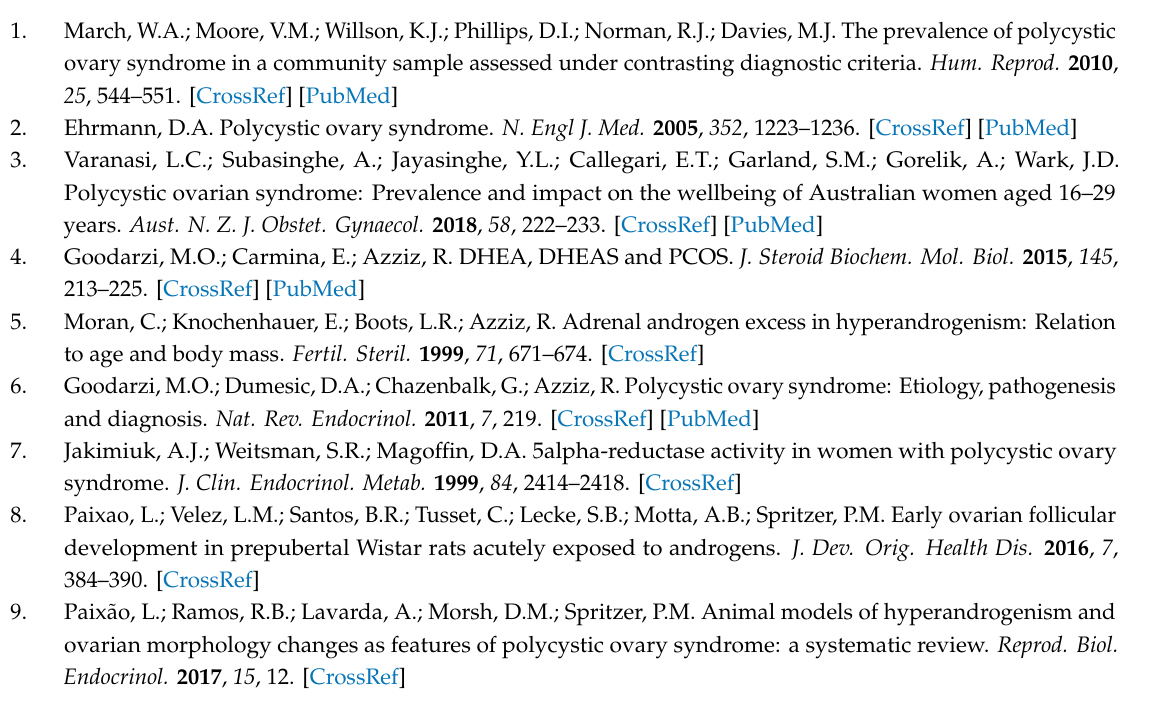
Figure S1: The property of AGE products. Figure S2. E ff ects of AGE products on the cell viability of KGN cells. Figure S3. The MG-BSA level in the serum and ovarian